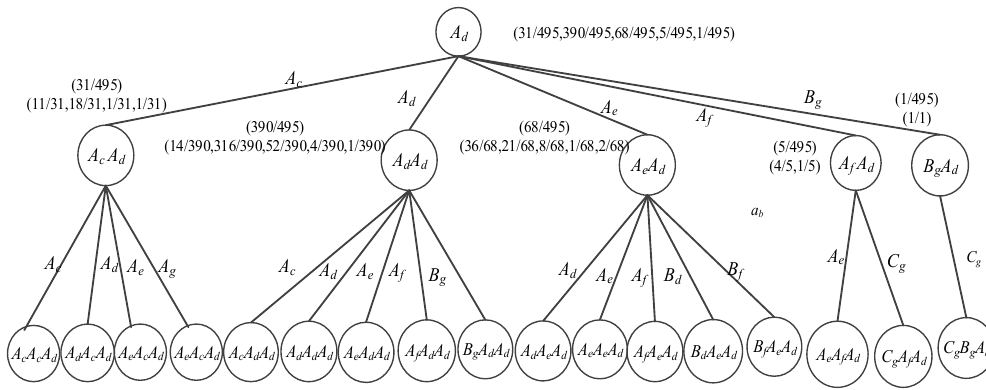
Figure 6. wPST tree representations for event A d .